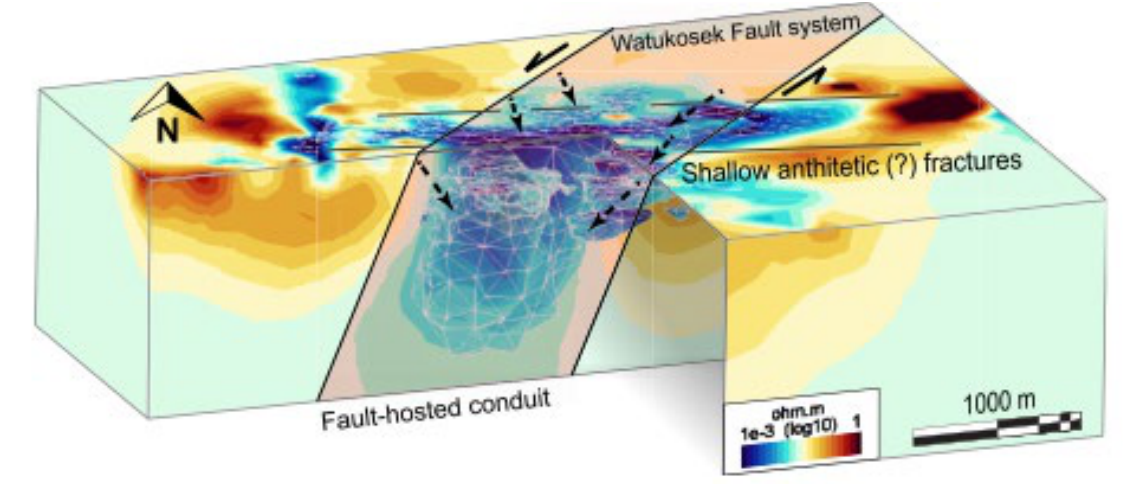
Figure 12. 3D projection of the acquired deep electrical resistivity tomography data. Extracted cells with resistivities below 2.5 Ohm.m underneath the active vents highlight the area of collapse (dashed black arrows). The red-shaded area indicates the Watukosek fault system that intersects Lusi [43].